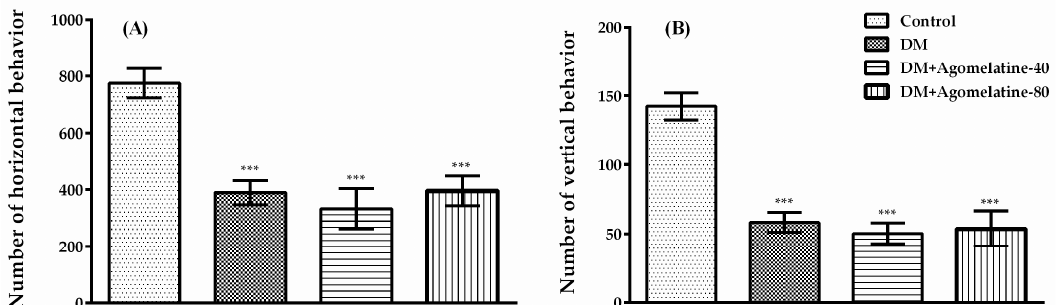
Figure 5. Number of ( A ) horizontal and ( B ) vertical locomotor activities of normoglycemic rats administered saline solution (control) and diabetic rats administered saline (DM), 40 mg/kg agomelatine or 80 mg/kg agomelatine for two weeks, in the activity cage test. Values are given as mean ± S.E.M. Significant difference against control group *** p < 0.001. One-way-ANOVA, post-hoc Tukey HSD multiple comparison test, n = 8.